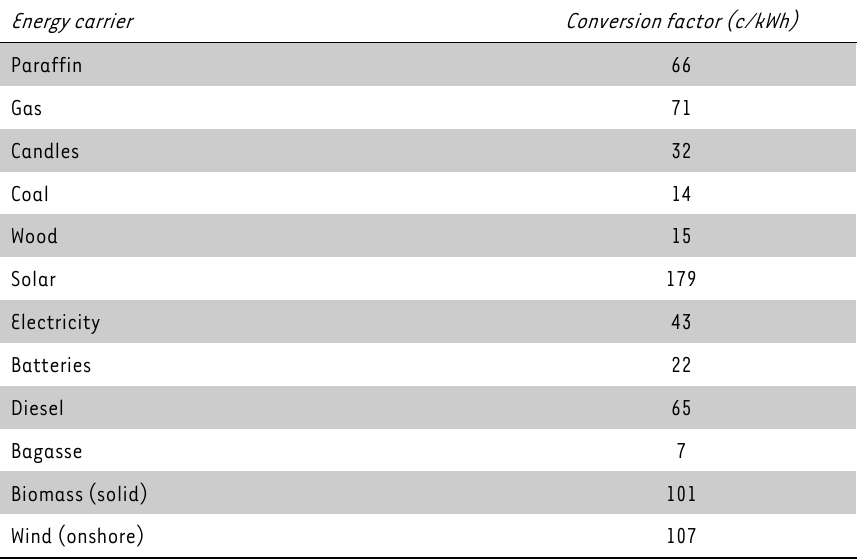
TABLE 1: Price to kWh conversion factors for each energy carrier Energy